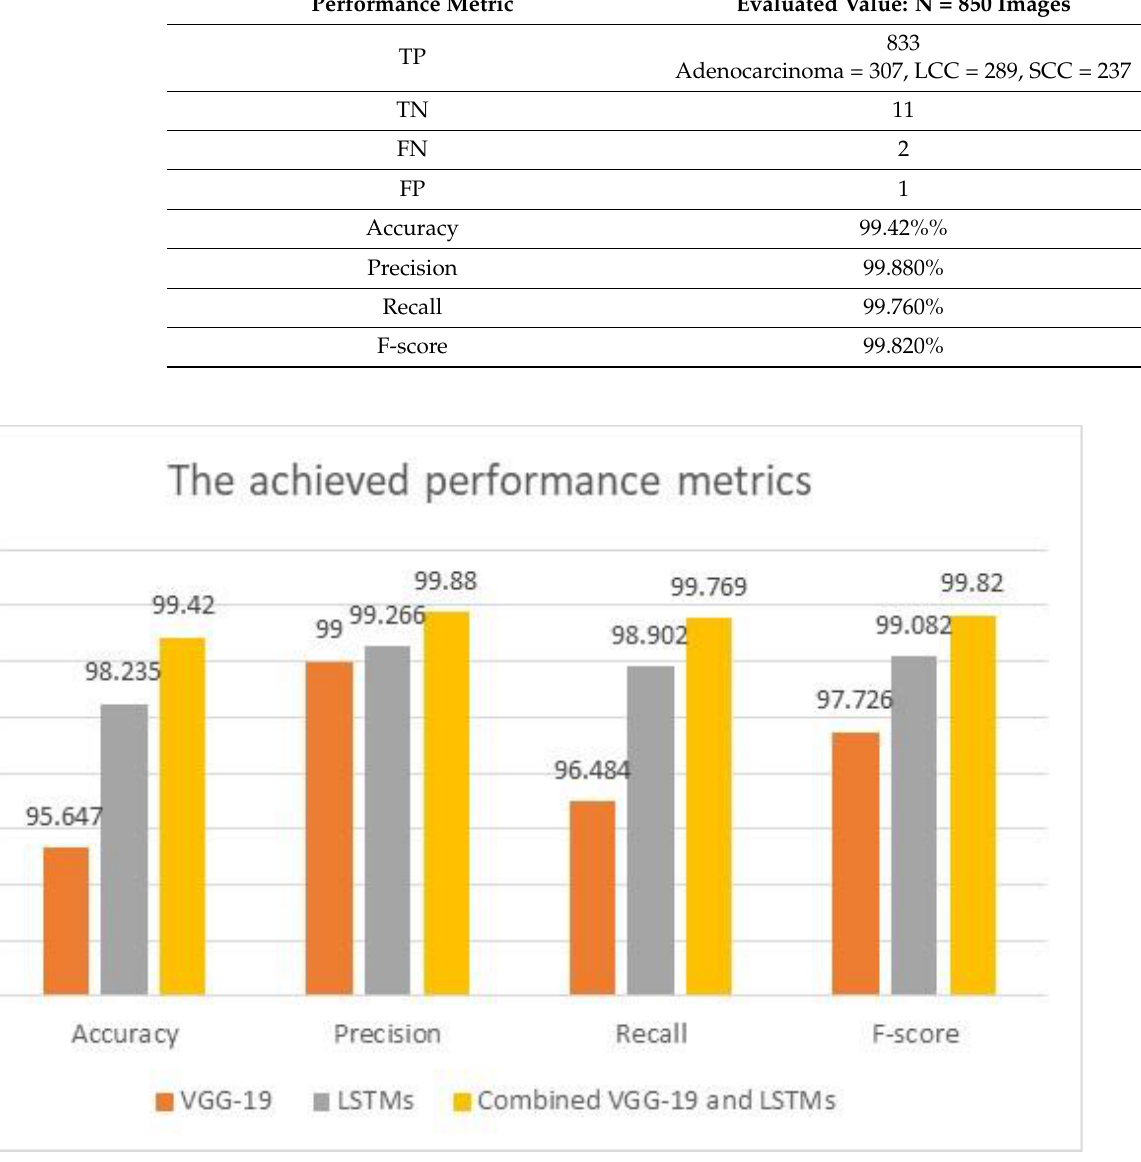
Figure 6. The evaluated performance metrics analysis. Using the VGG-19 model standalone, the first scheme achieved the minimum results for all considered metrics, while the LSTMs reached better values. The last scheme, combin- ing both techniques, achieved the highest outcomes for the considered metrics, as shown in Figure 6. Table 7 lists the comparison results for the average accuracy, precision, and